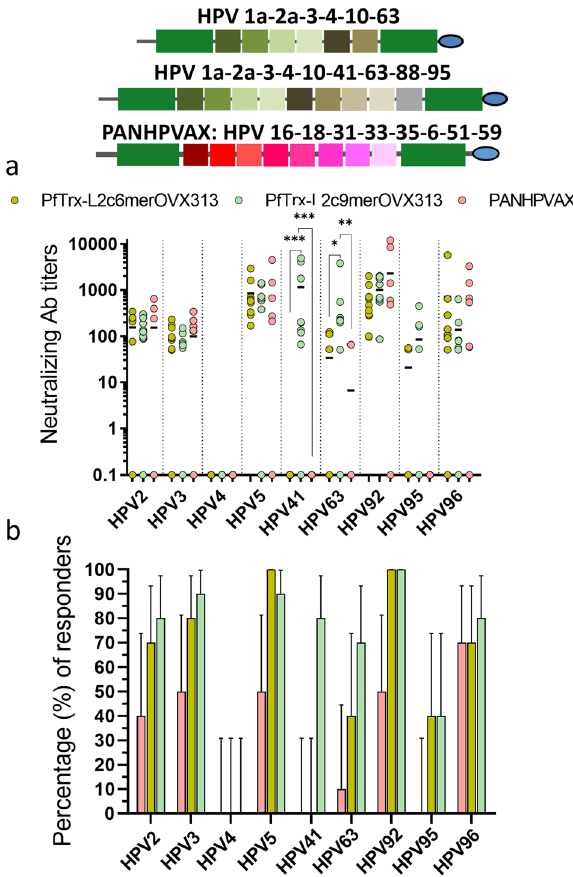
Fig. 3 PfTrx-L2c6merOVX313 and PfTrx-L2c9merOVX313 outperform the PANHPVAX vaccine with regard to broadness of the induced immune response to cutaneous HPV types. a Neutralizing antibody titers to nine HPV types measured by the L1-PBNA in sera from 10 mice immunized with 20 µg of the PfTrx-L2c6merOVX313 antigen, PfTrx-L2c9merOVX313 and PANHPVAX (note the antigen/color designation on top of the graph). Each dot represents the EC50 value derived from one animal serum; horizontal lines correspond to the mean of neutralizing antibody titers. The three antigens are illustrated on the top of panel a. A P- value of ≤ 0.05 was considered signi fi cant. * P < 0.05; ** P < 0.01; *** P < 0.001, as determined by the nonparametric Mann – Whitney test. b Percentage (%) of responders showing neutralizing antibody levels induced by the three antigens. The lines on top of each bar represent the upper 95% con fi dence interval. EC50 values <50 were considered non-neutralizing and therefore set to